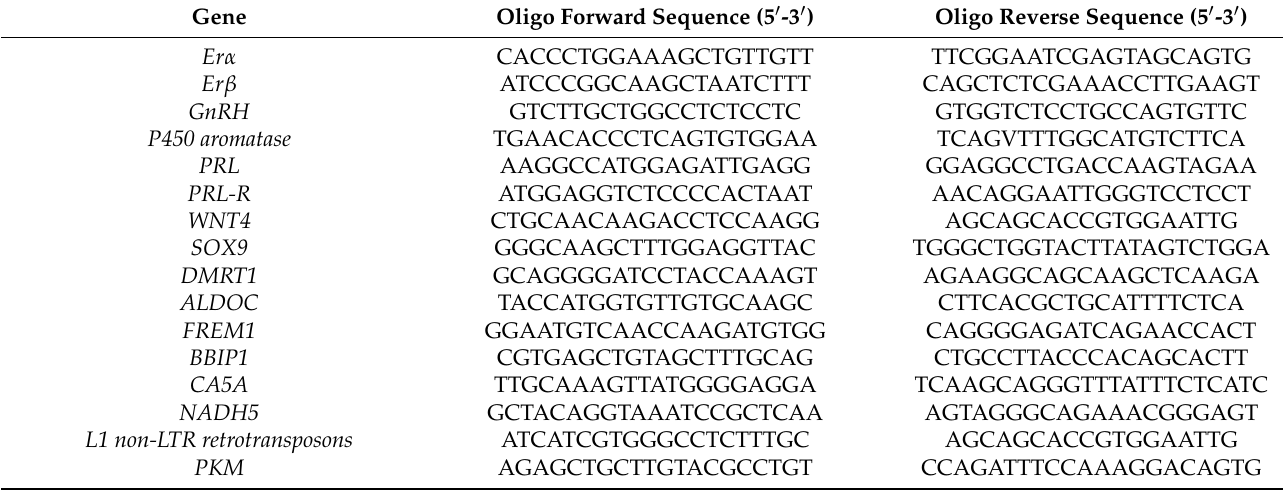
Table 1. Primers used in the qRT-PCR analysis performed to validate the expression profiles of the studied